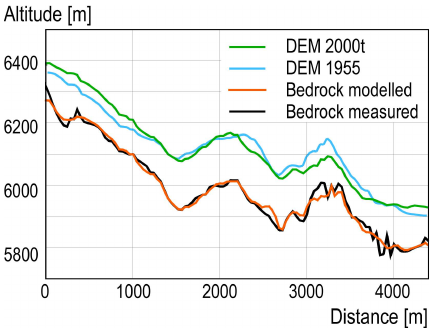
Fig. 11. Ice thickness measured vs. modelled (transects 2, 3 and